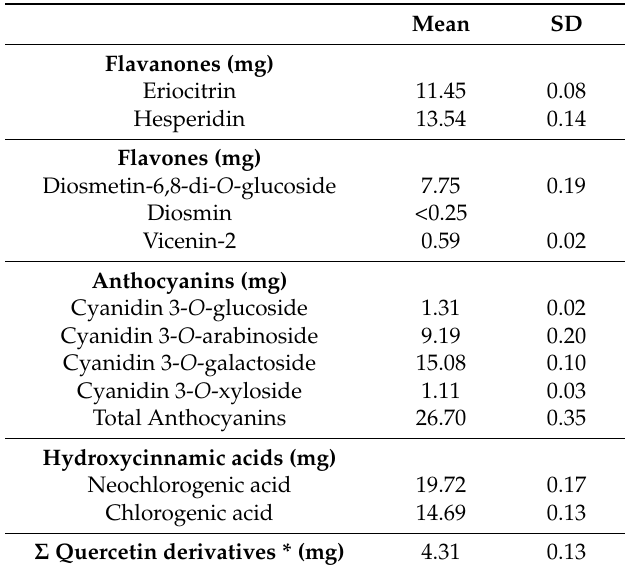
Table 2. Phenolic composition of aronia-citrus juice (per 100 mL).